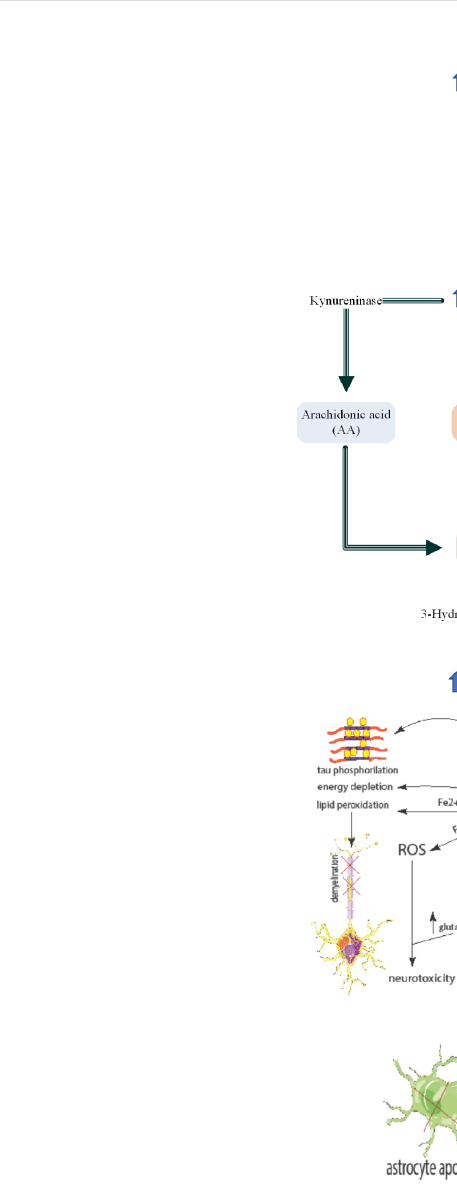
FIGURE 2 Kynurenine pathway and roles of QUIN in MS pathogenesis. In fl ammatory cytokines such as TNF- a and INF- a which are increased in MS patients blood circulation. These induce increased activity and levels of IDO and KMO in macrophages. Higher activity of these enzymes leads to KP activation and thus high levels of QUIN is secreted to the blood. The increased QUIN can pass the BBB and enter the brain parenchyma. This QUIN is together with the QUIN secreted by microglia lead to several pathological mechanisms: 1) NMDA receptor activation in the cells and therefore higher intracellular calcium. 2) increased glutamate release by neurons and decreased glutamate uptake into synaptic vesicles by astrocytes. These cause higher glutamate levels in the micro-environment which cause neurotoxicity. 3) Increased ROS formation which causes neurotoxicity. 4) Lipid peroxidation that can lead to demyelination. 5) Energy depletion 6) Tau phosphorylation. The mentioned mechanisms, generally cause apoptosis of astrocytes, oligodendrocytes (an important cell in myelin production), and neurons. Parts of the fi gure were